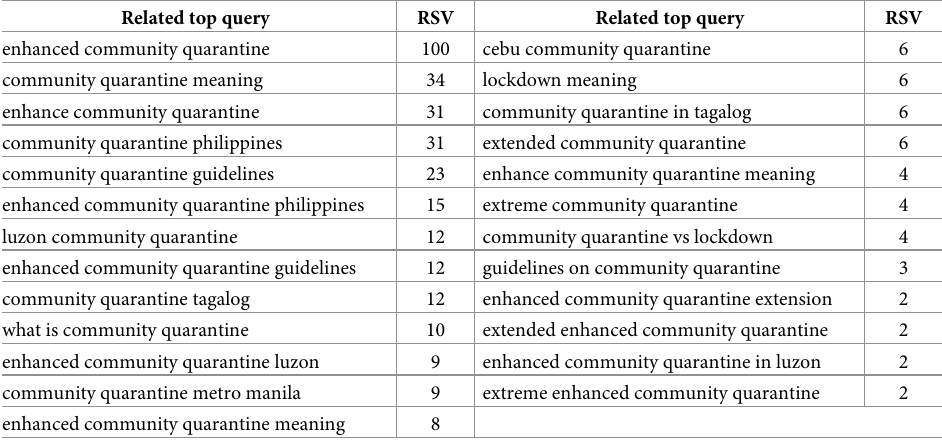
Table 5. Related top queries and search interest value for “community quarantine”.